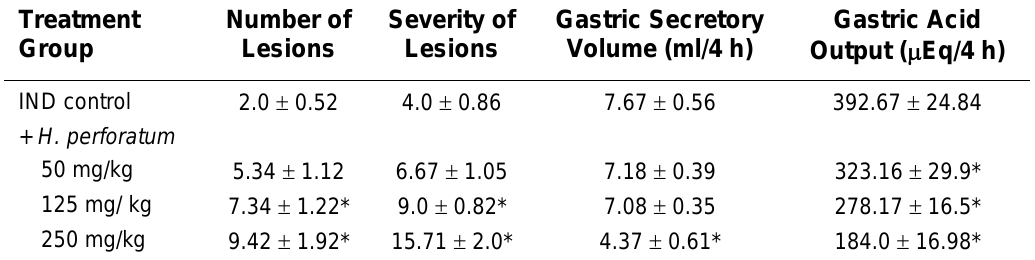
Effect of H. perforatum Extract on Gastric Mucosal Injury Induced by Indomethacin in Pylorus-Ligated